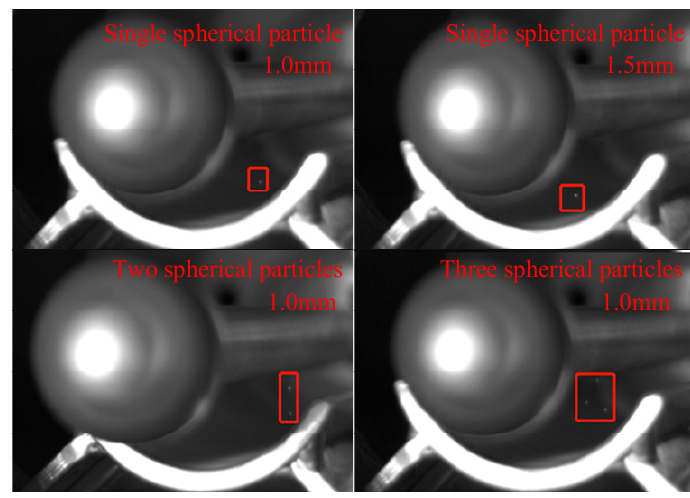
Figure 3. Movement images of spherical particles.